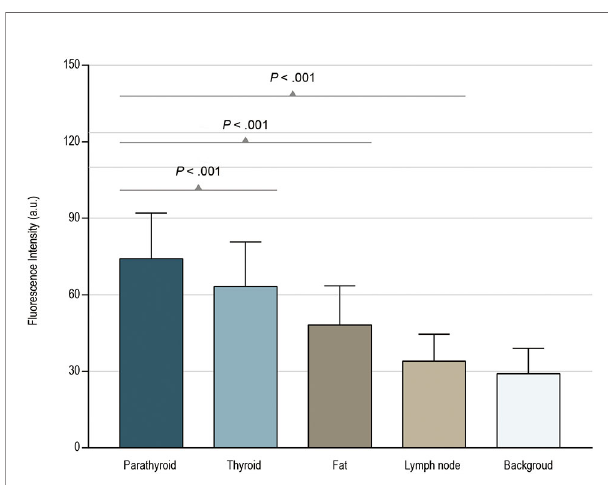
FIGURE 3 | Paired-samples t-test of fl uorescence intensity in different